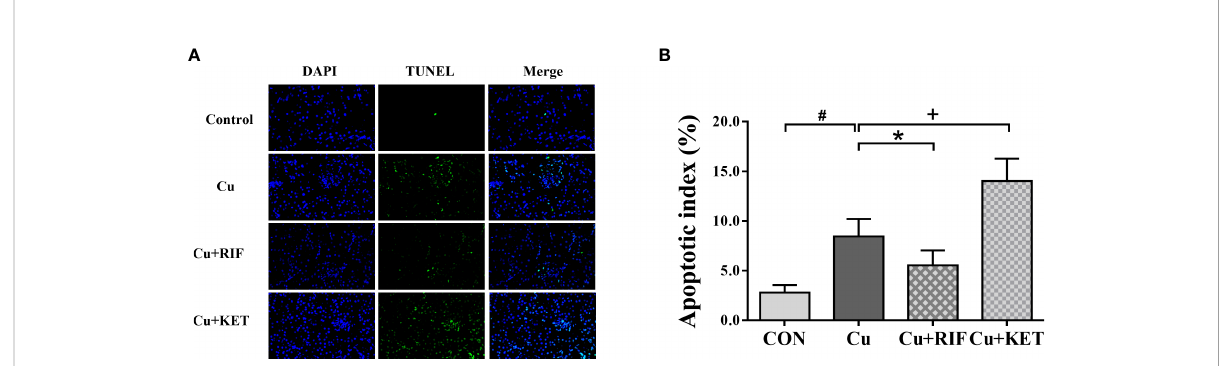
FIGURE 6 Representative DAPI and TUNEL double staining of liver in largemouth bass subjected to RIF or KET under Cu exposure (n = 6). TUNEL-positive cells were stained and indicated by bright green fl uorescence indicating apoptotic cells, and normal nuclei appear in blue. (A) TUNEL